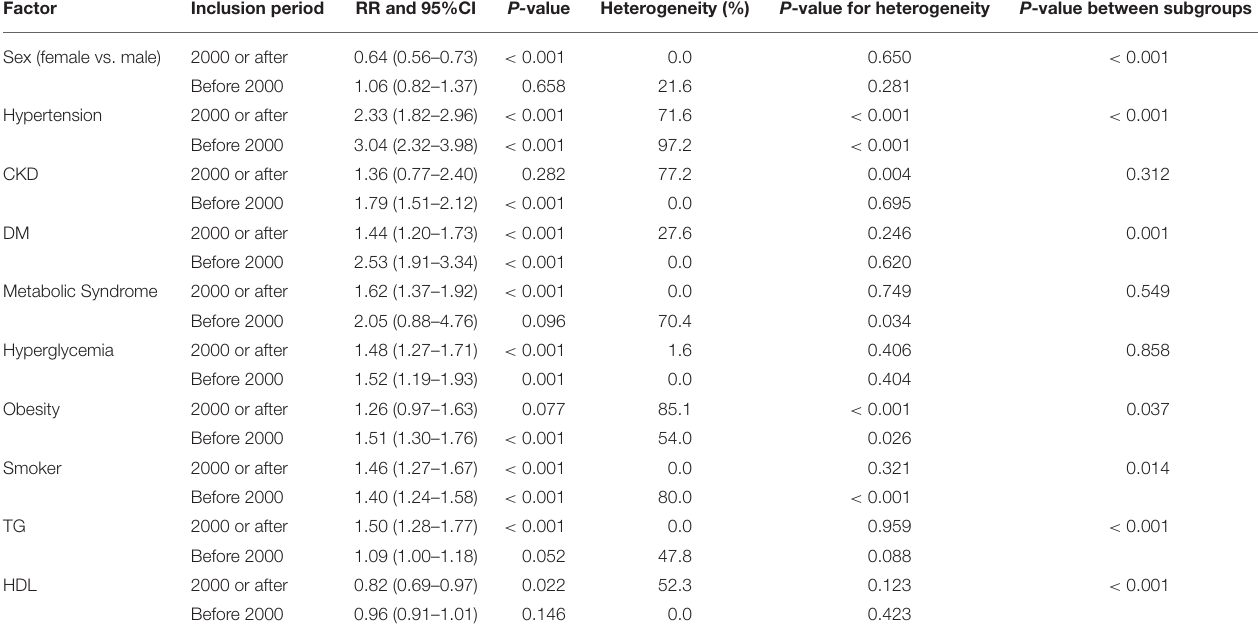
TABLE 3 | Subgroup analysis of stroke incidence based on inclusion period. Factor Inclusion period RR and 95%CI P- value Heterogeneity (%) P -value for heterogeneity P -value between subgroups Sex (female vs.